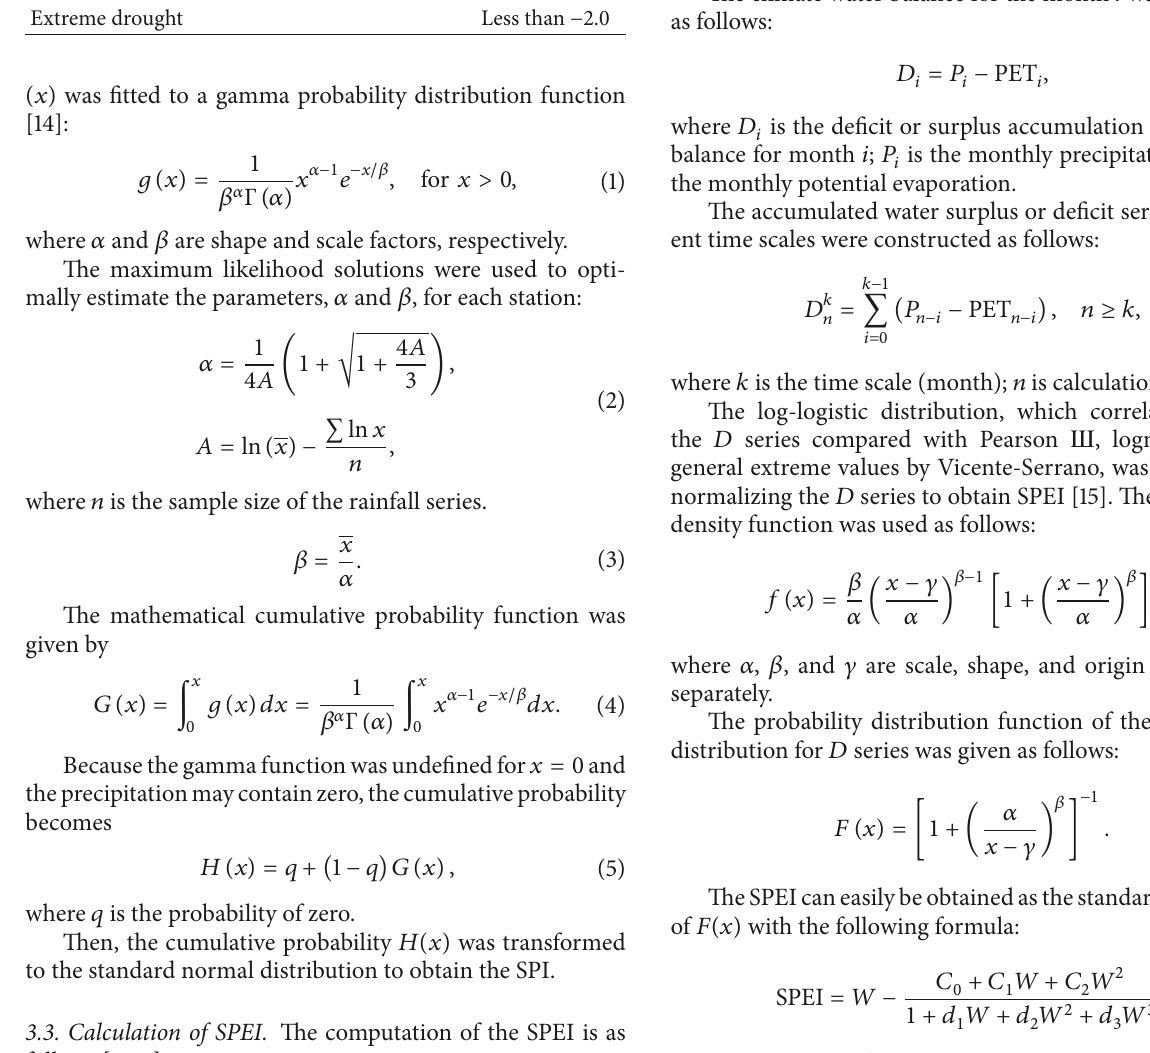
Table 1: Classification standard of drought based on SPEI. Drought classification SPEI Normal More than − 0.49 Light drought − 0.99 to − 0.5 Moderate drought Severe drought − 1.99 to − 1.5 Extreme drought Less than −